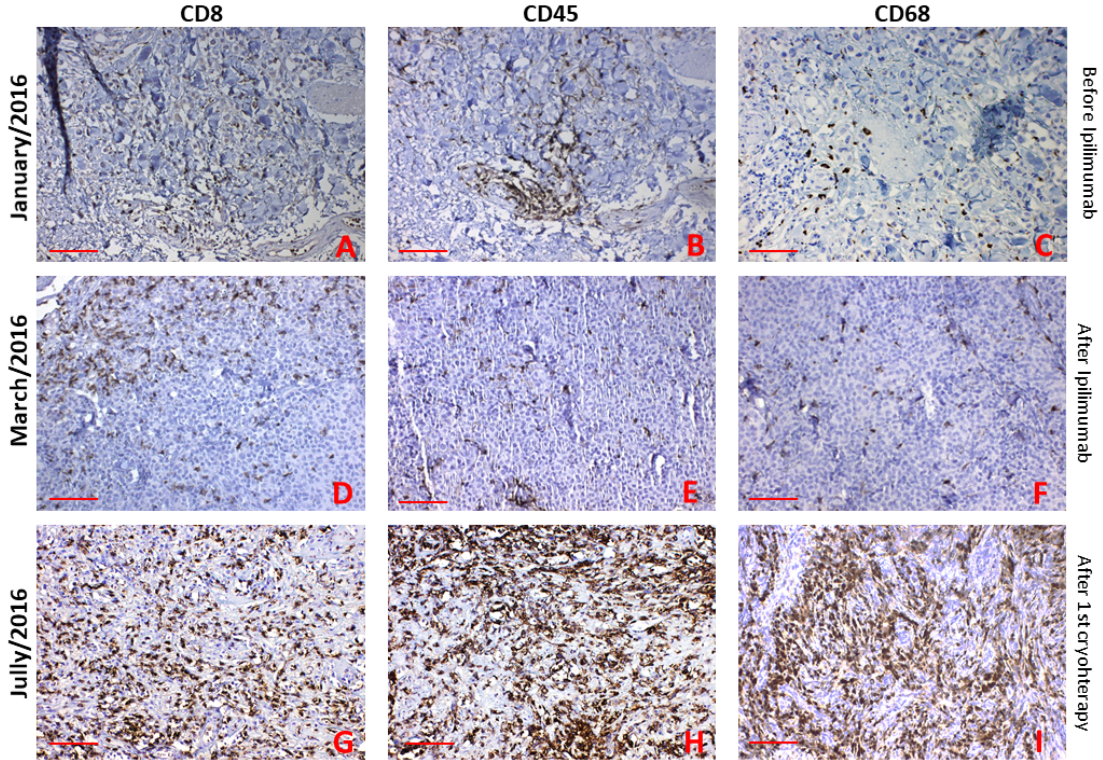
Figure 5. Immunohistochemical staining of TILs was also made. TILs were detected as only small perivascular infiltrate CD8 and CD45 positive cells before ipilimumab treatment ( A , B ). CD68 positive macrophages were seen as small diffuse infiltrate ( C ). CD8 positive T cells were observed at the edge of the tumour ( D ), and small diffuse infiltrates of CD45 and CD68 positive cells were observed after ipilimumab treatment ( E , F ). Significant and massive infiltrates of CD8, CD45 T cells and CD68 positive macrophages were observed in the skin metastasis after the first cryotherapy ( G – I ). Bar 50 µ m.